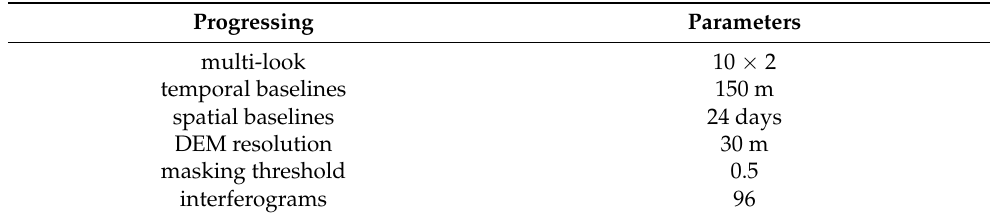
Table 2. The parameters of SBAS-InSAR